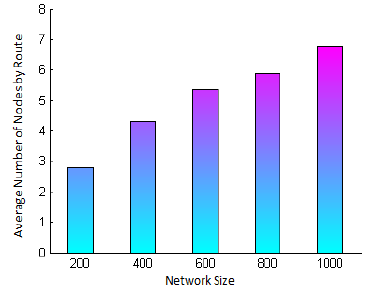
Figure 10. Average number hops to the base station, for different network